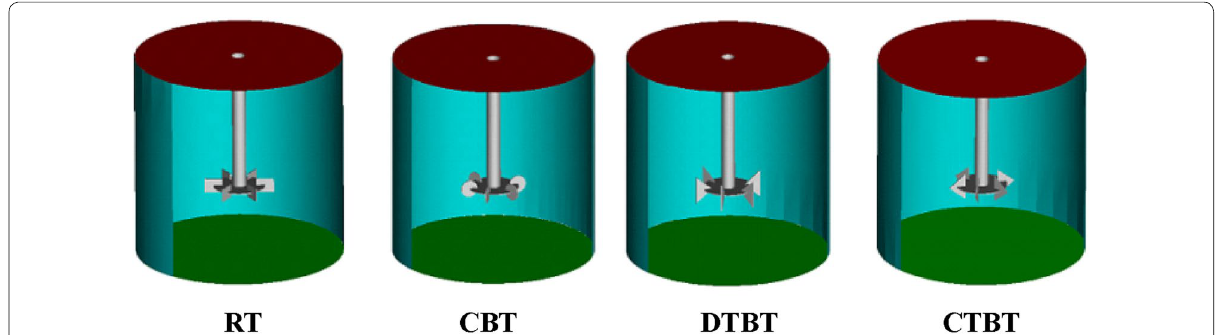
Figure 3 Stirred vessel configurations without